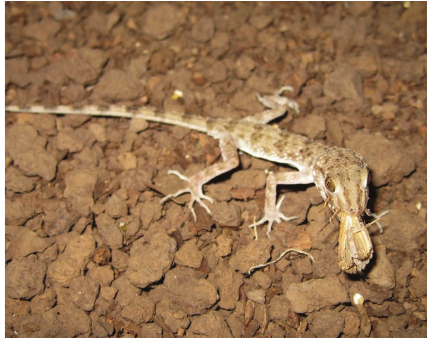
Figure 1: Capturing the prey by T. caspius at midnight in Sari, Iran Babaei Savasari, 2011.